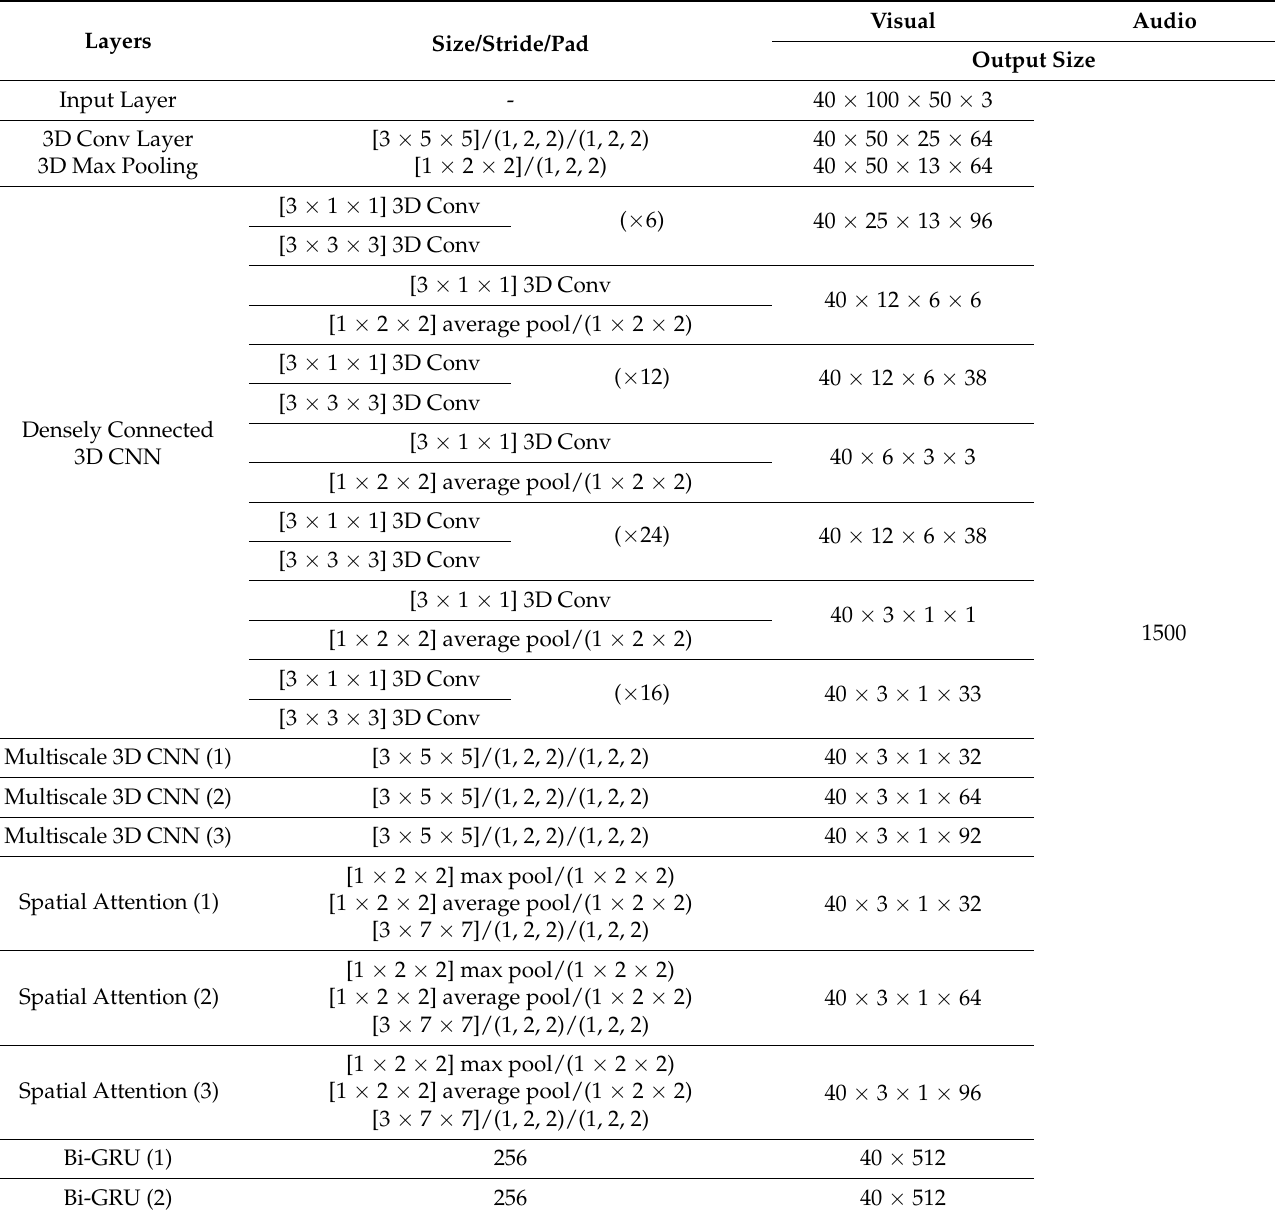
Table A1. Hyperparameters associated with the proposed